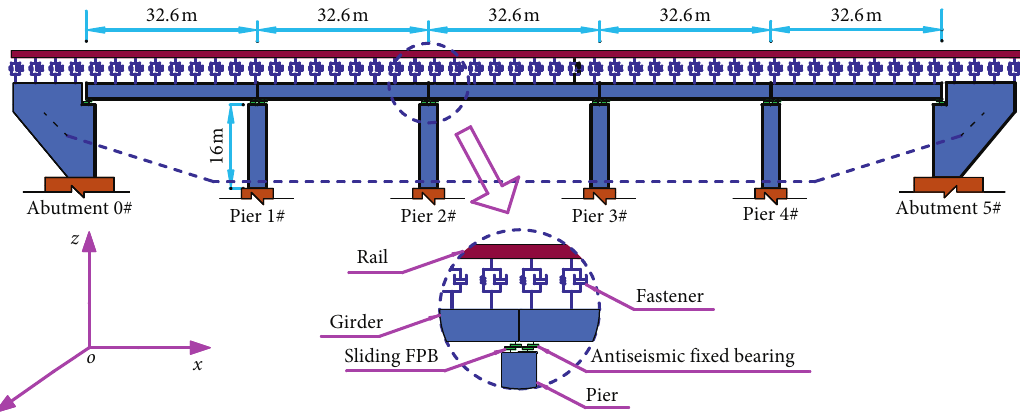
Figure 7: Schematic of the five-span simply supported bridge.